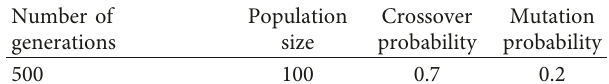
Table 7: Initial parameters of NSGA-II.